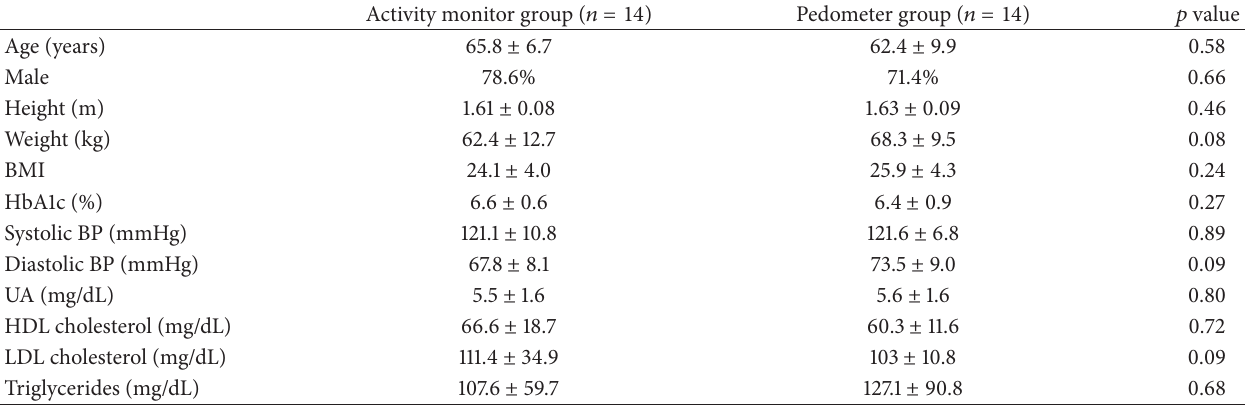
Table 2: Clinical background of patients in whom medications were not changed throughout the